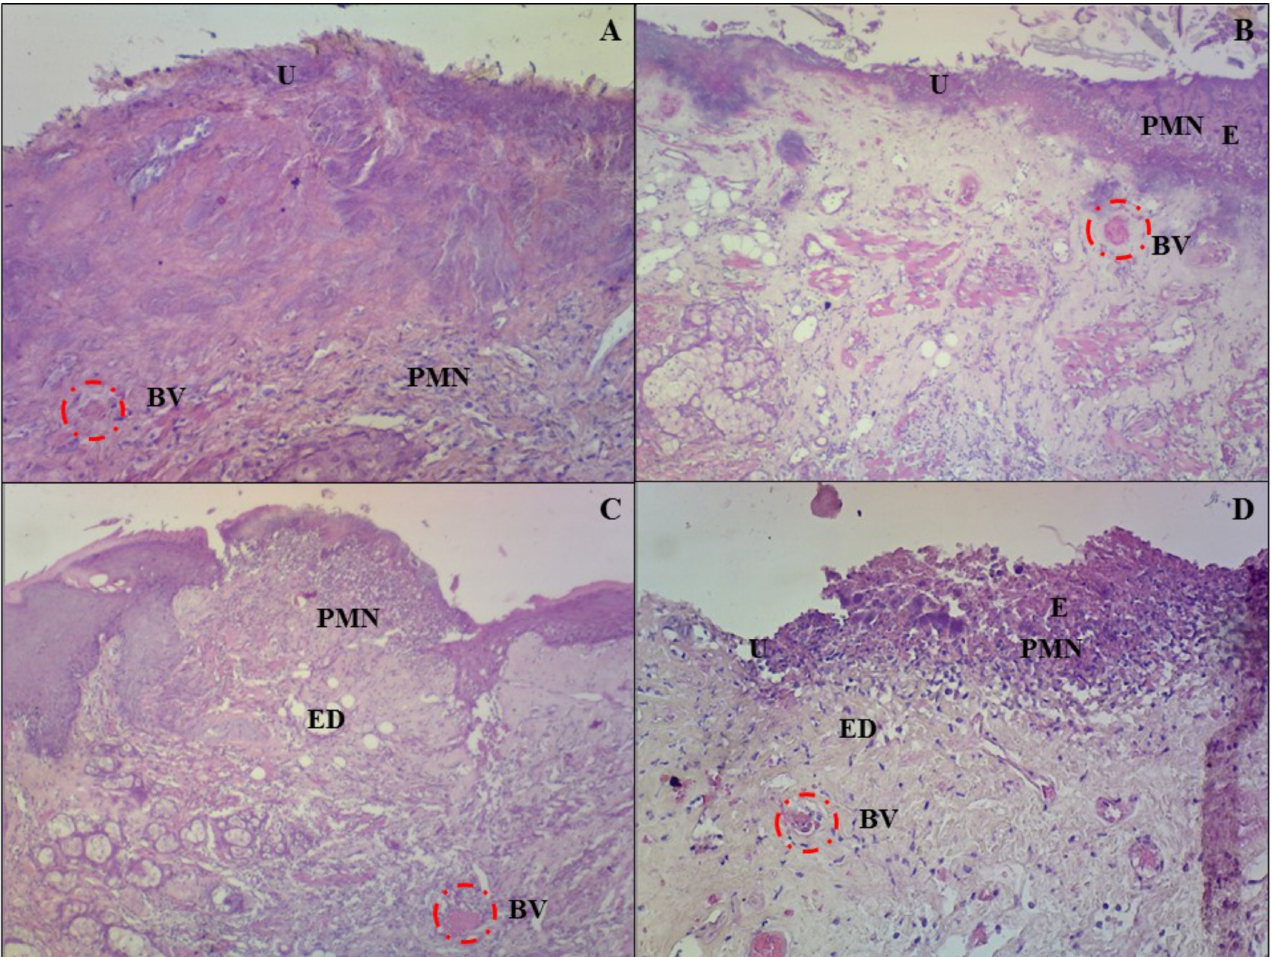
FIGURE 4 - Microscopic aspects of groups at seven days of experimentation. A Group treated with gel base (Borneol 0%); B Group treated with gel (Borneol 1.2%); C Group treated with gel (Borneol 2.4%); and D Group (Negative control). PMN=Polymorphonuclear cells; BV=Blood vessel; U=Ulcerated area; E=Exocytosis; ED=edema. Magnification x10. HE